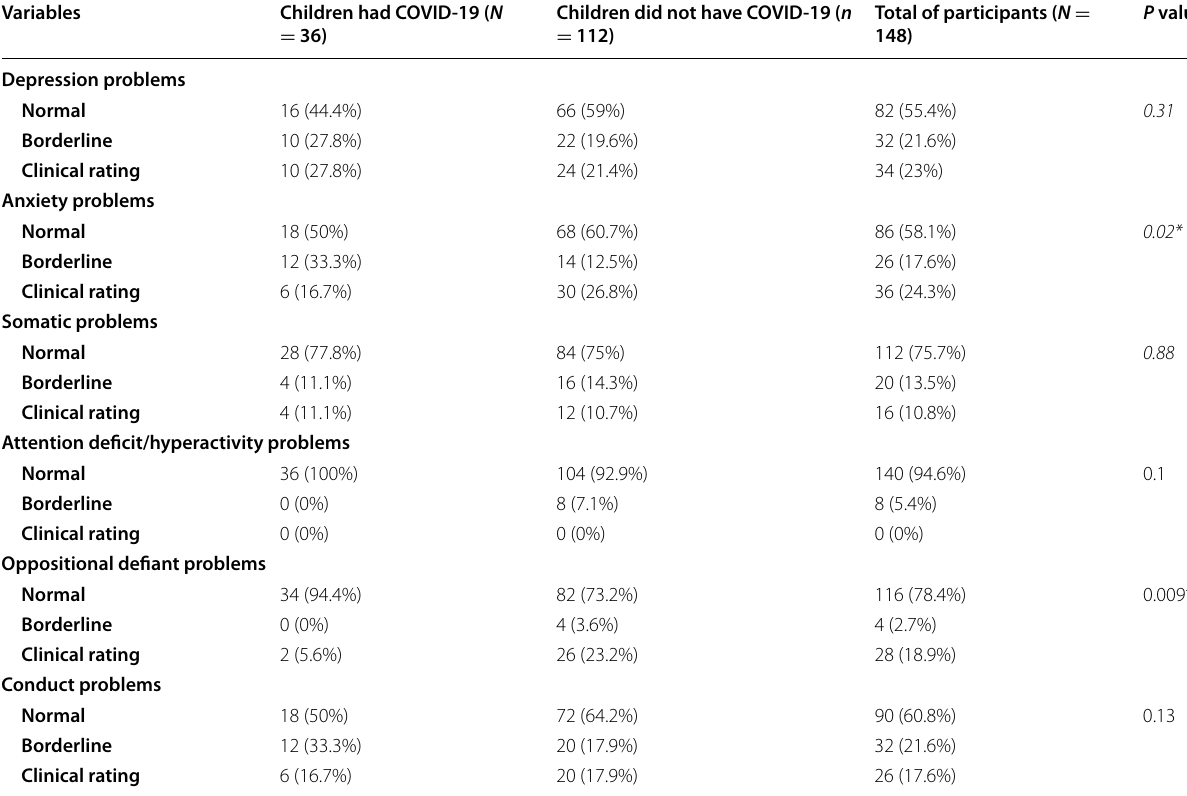
Table 4 CBCL Profile of DSM-5 scales of studied